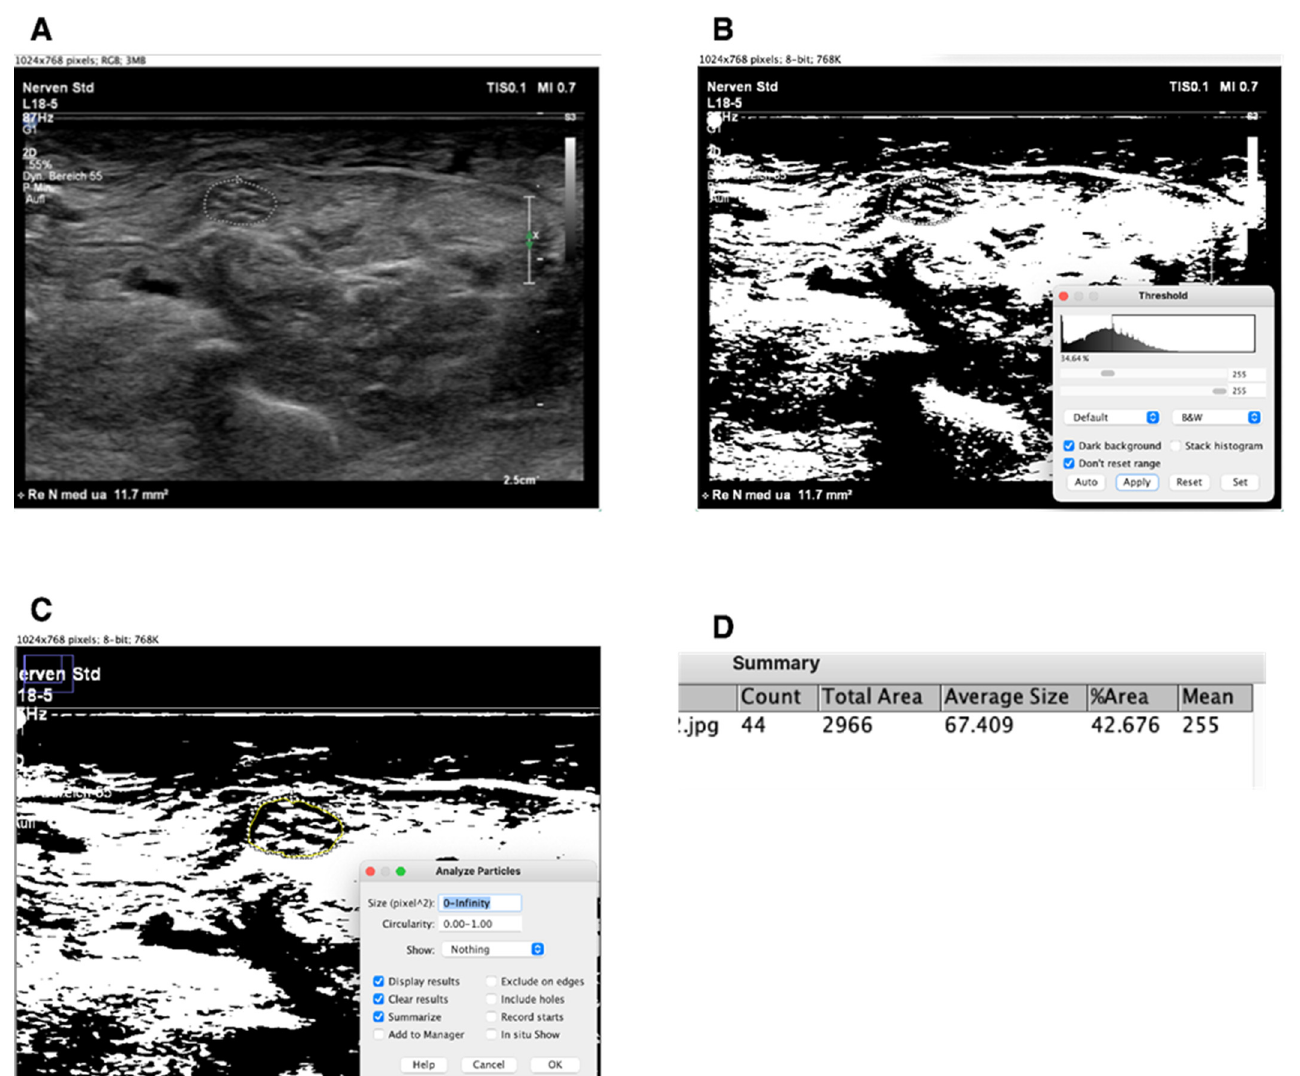
Figure 1. Analyzing ultrasound pictures in Image J. ( A ) = median nerve (position lower arm) in a raw ultrasound picture; ( B ) = the same image converted to 8-bit and modifying threshold to black and white. Automatic threshold function is presented in the lower right corner of the picture in the small window; ( C ) = now the median nerve in the image is bordered by freehand tracing; settings for analysis of the traced particles are shown on the window on the bottoms right; ( D ) = finished analysis of the traced particle, the result shows the fraction of white in %. The fraction of black is the difference from 100 minus the fraction of white.